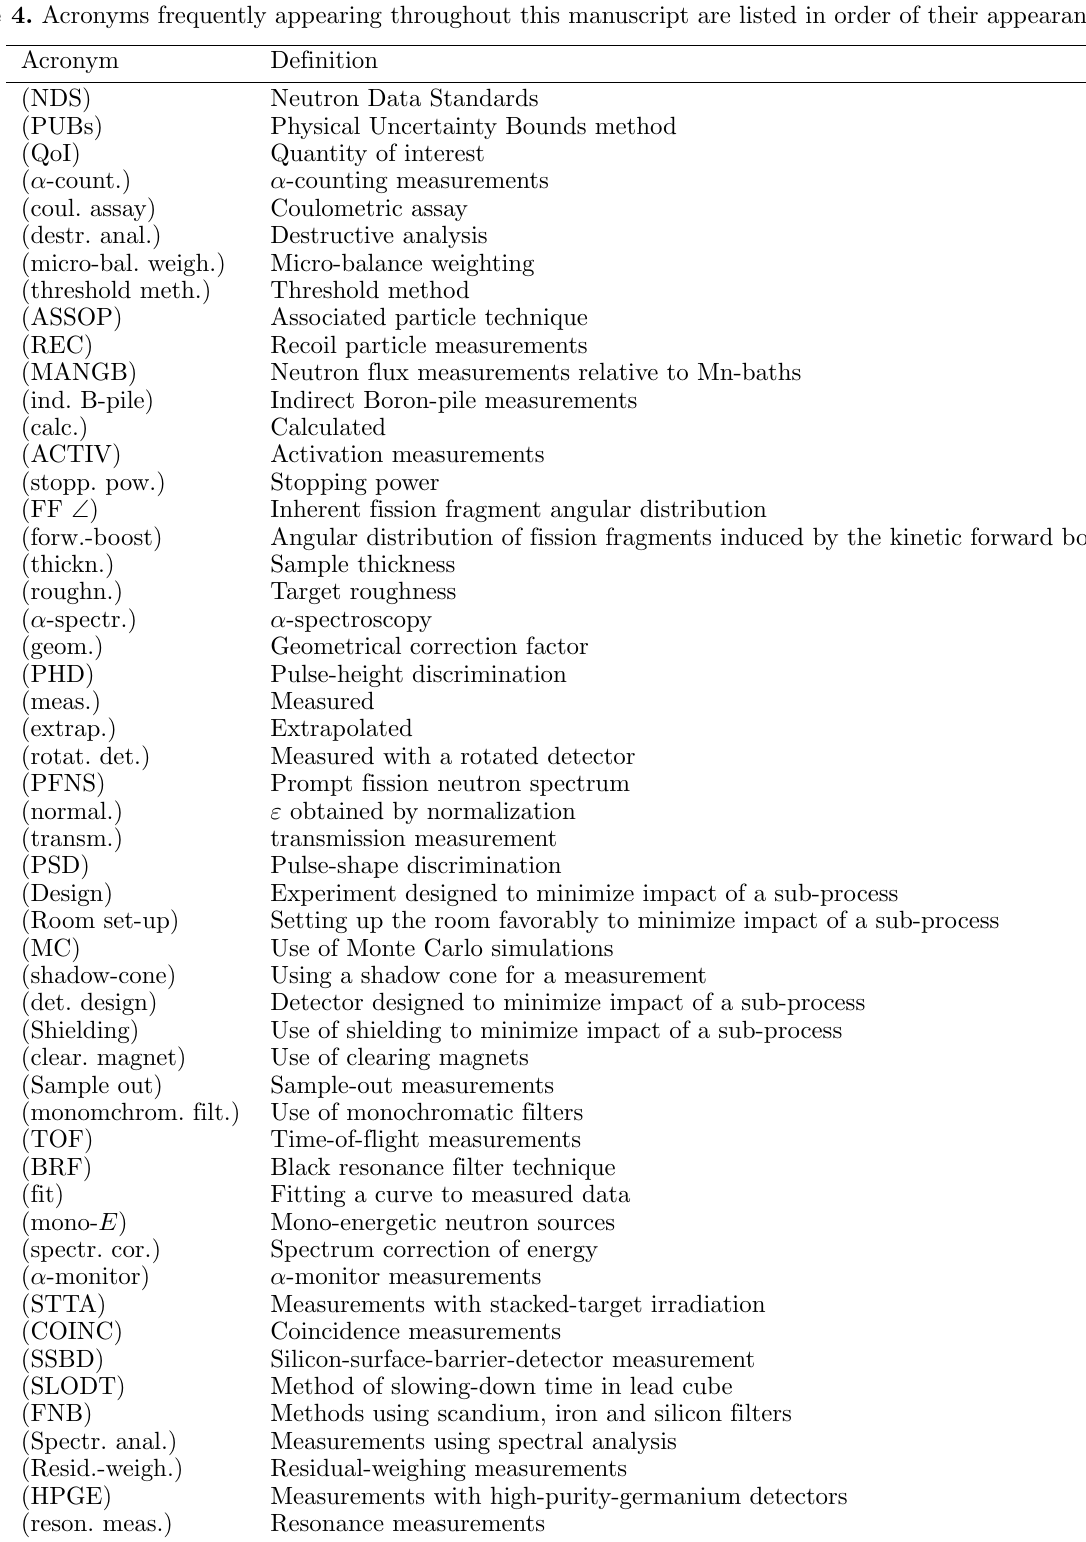
Table 4. Acronyms frequently appearing throughout this manuscript are listed in order of their